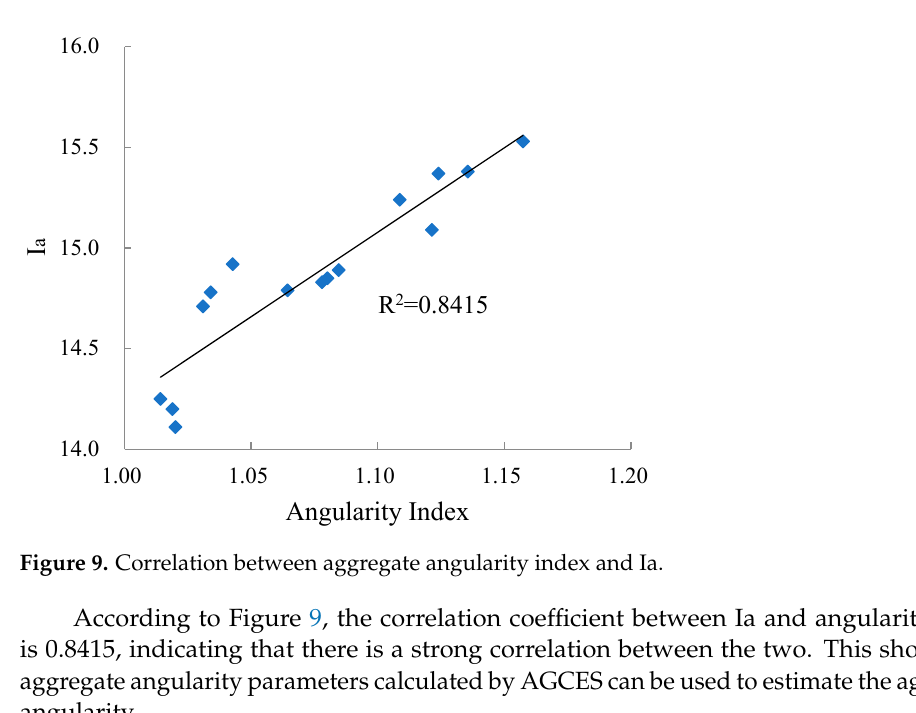
10 of 17 ( c ) Figure 8. Correlation between aggregate form evaluation indices: ( a ) Shape index and shape fac- tor, ( b ) Shape index and form factor, ( c ) Shape factor and form factor. It can be seen from Figure 8 that there is a strong correlation between shape index and shape factor, and a good correlation between shape factor and form factor, indicating that there is partial overlap between shape factor and two other evaluation indicators. In addition, the correlation coefficient between shape index and form factor is only 0.65, much weaker than the correlation coefficient between shape index and shape factor, and between shape factor and form factor. Therefore, in subsequent studies, only shape index and form factor were used to evaluate the form properties of aggregate.